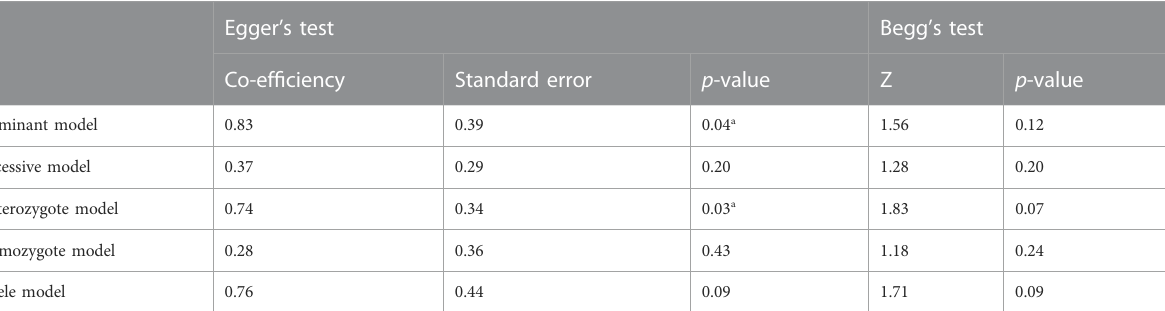
TABLE 7 Publication bias of included